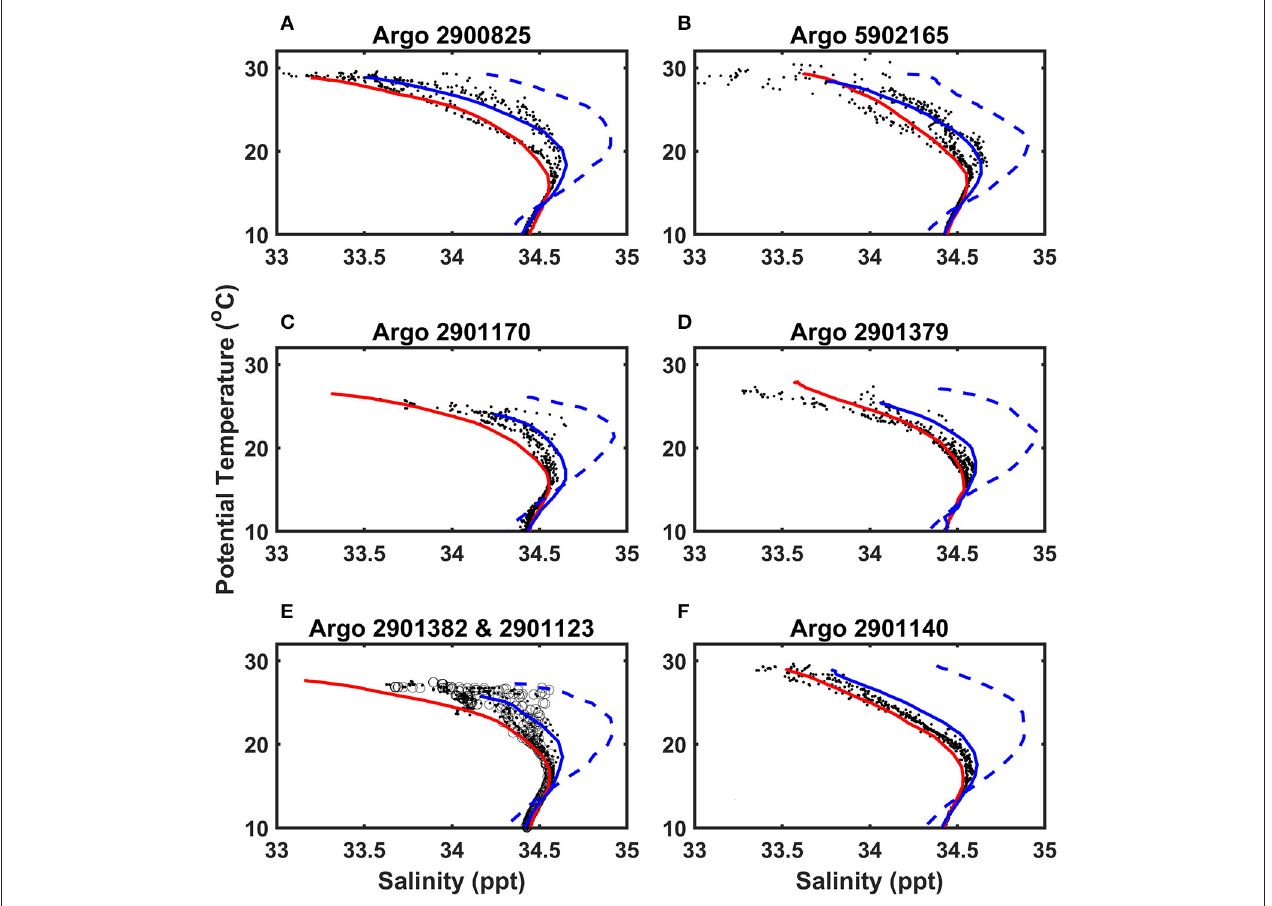
FIGURE 12 | Temperature-salinity (TS) diagrams during the month and a month before observing the ocean eddies via Argos (A) 2900825, (B) 5902165, (C) 2901170, (D) 2901379, (E) 2901382, 2901123, and (F) 2901140. The left and right panels are for anticyclonic and cyclonic eddies, respectively. The solid red and dashed blue curve represents the TS properties of water masses in the southern South China Sea (SCS) and in the Kuroshio region, respectively. In (E) , the dots are for the TS obtained from Argo 2901123 and the circles are for Argo 2901382, observing the same anticyclonic eddy with significant downwelling.